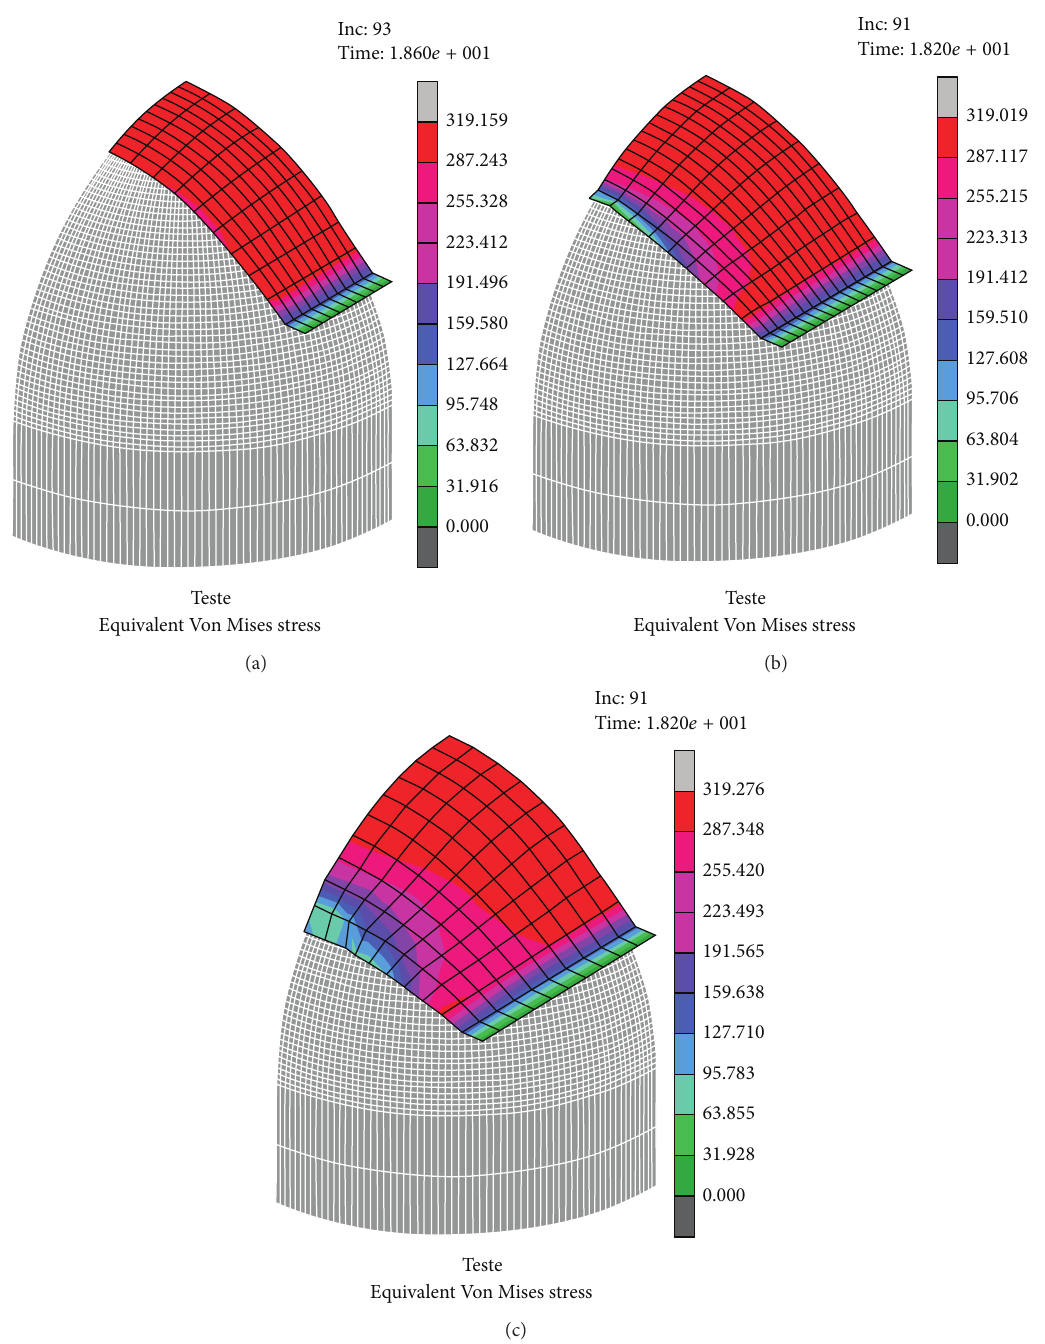
Figure 32: Von Mises stress distribution in MSC-MARC for the Nakajima tests in CS1 condition: (a) 100mm, (b) 150mm, and (c) 200